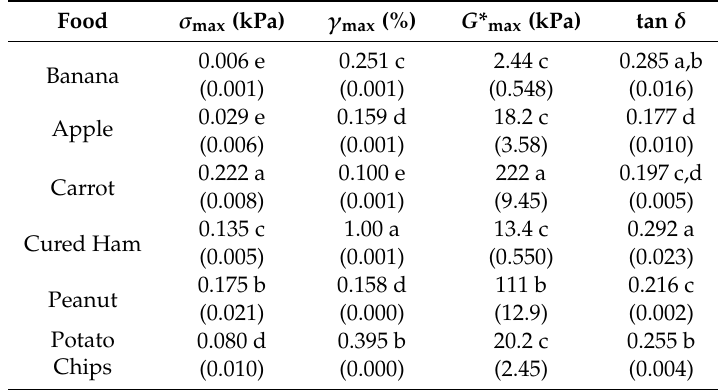
Table 3. Rheological properties of boluses (limit values of linear viscoelastic (LVE) range) obtained from amplitude